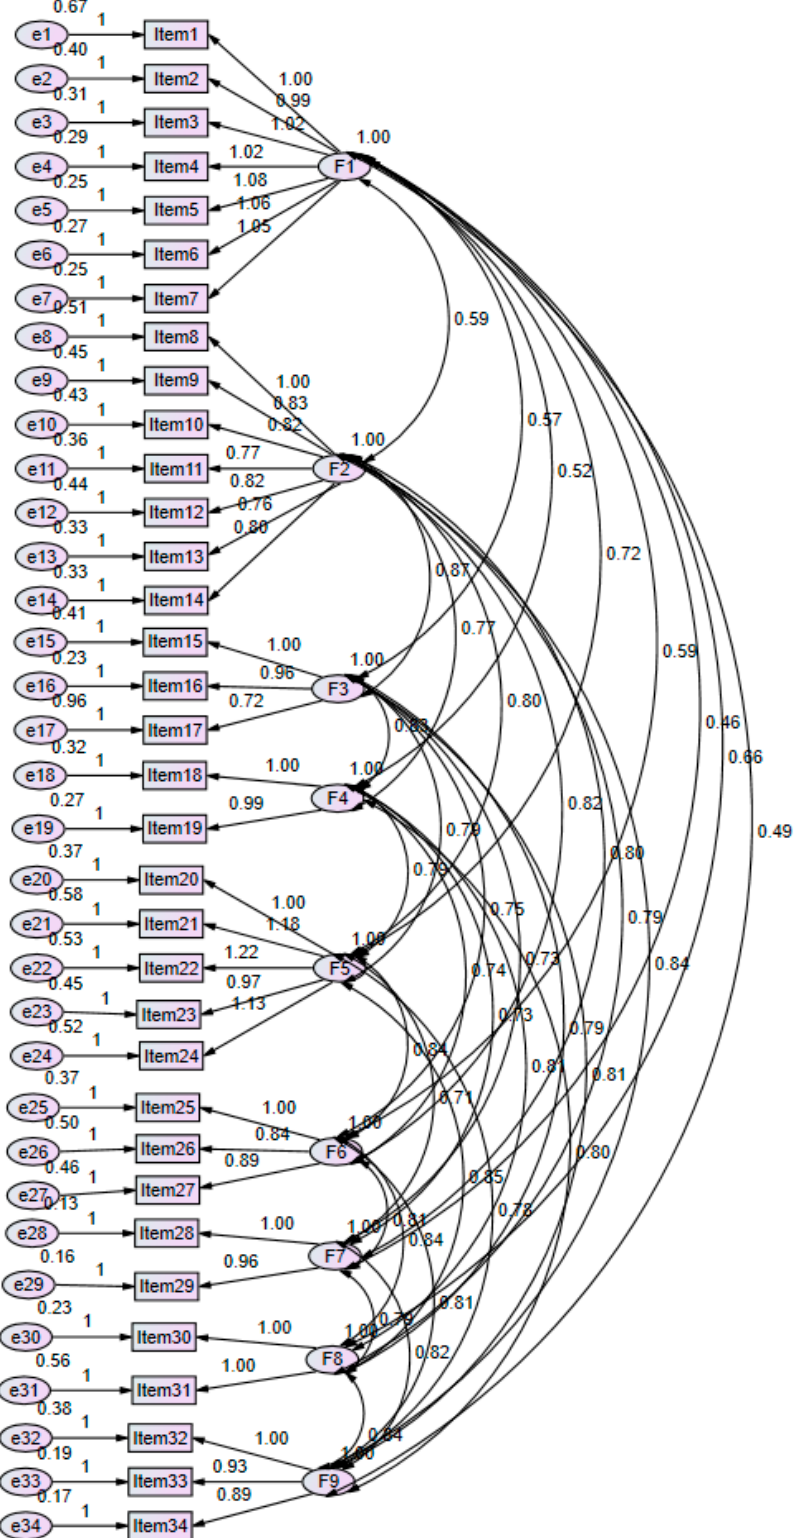
Figure 1. The detailed coefficients for the factor structure of the GSCS-Chinese version.